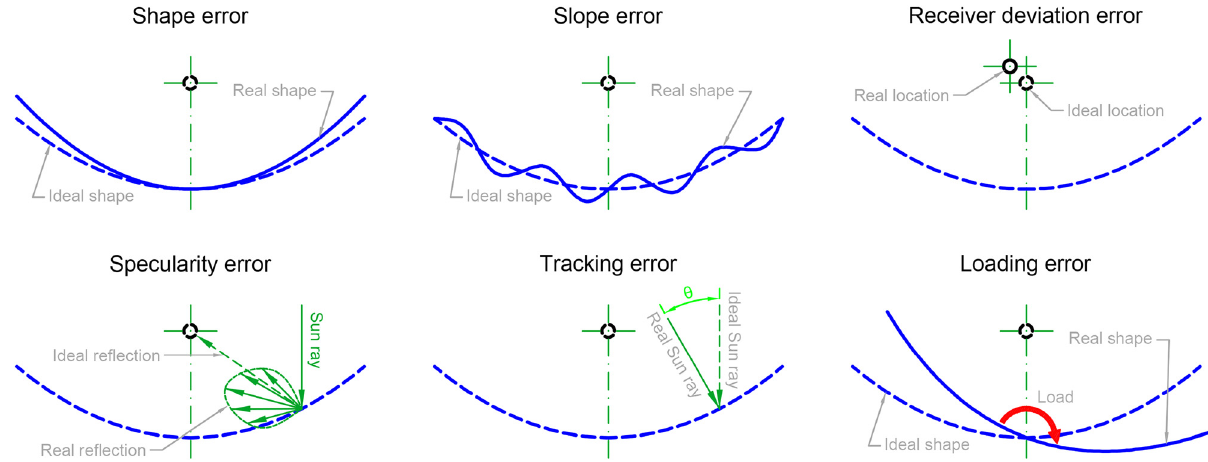
Figure 4: Geometrical errors in